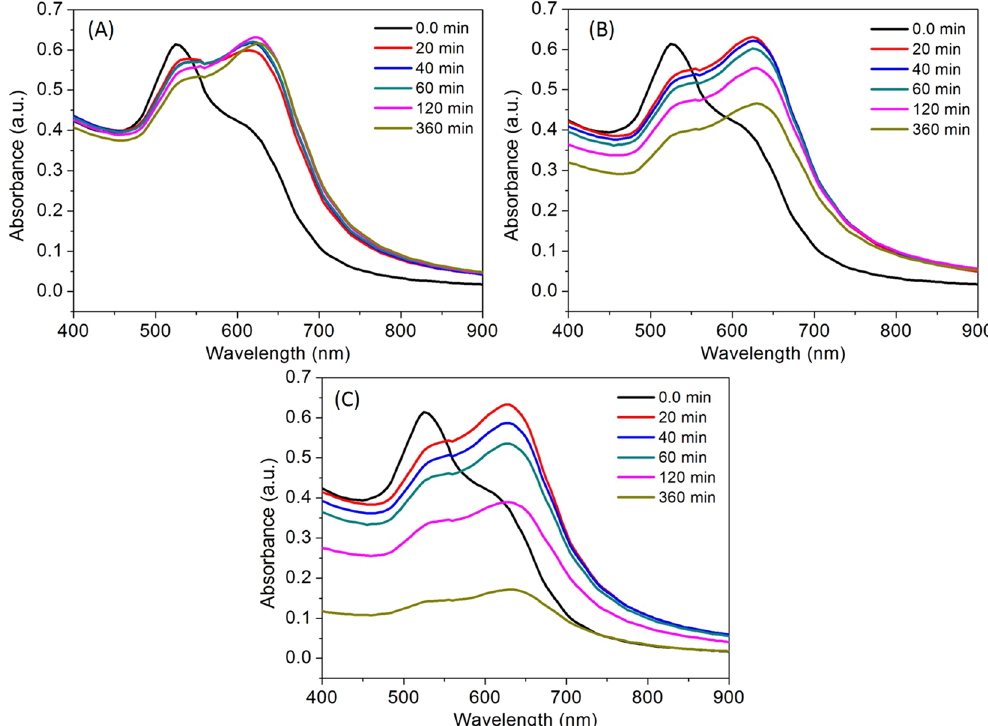
Figure 5. ( A ) Time course of the spectral response of the AuNPs at 0.45 µ mol L − 1 Mg 2 + , ( B ) Time course of the spectral response of the AuNPs at 0.50 µ mol L − 1 Mg 2 + , ( A ) Time course of the spectral response of the AuNPs at 0.55 µ mol L − 1 Mg 2 +